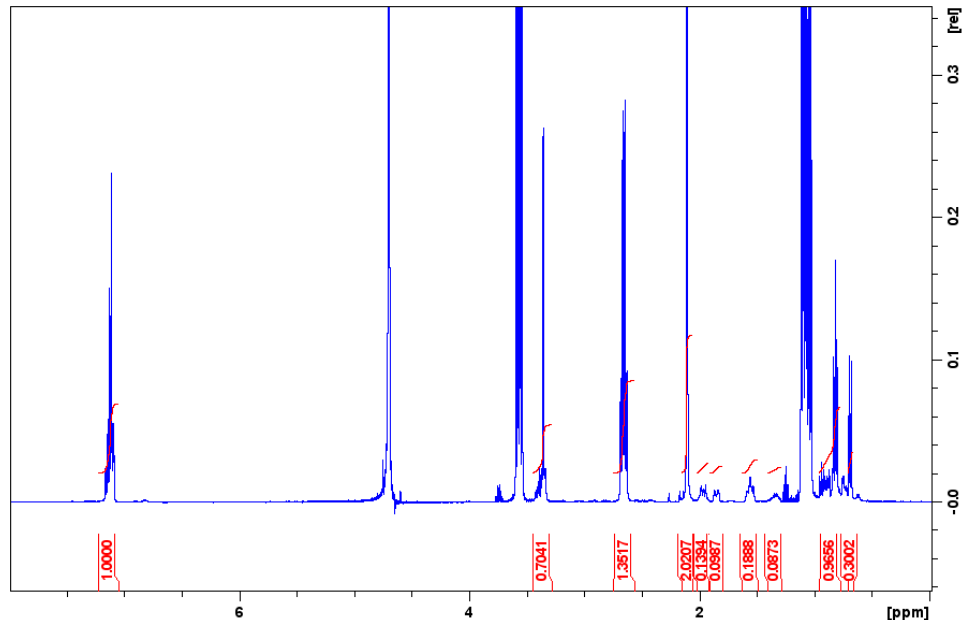
Figure 7. 1 H NMR spectrum of the lidocaine/ DL -menthol system after solubilization of the Lido: DL M cocrystal in D 2 O for 24 h. x axis: chemical shift δ in ppm (part per million), y axis: integral (number of proton) in relative unit. The red curves correspond to the integration peak: The height of the curve is proportional to the number of protons.